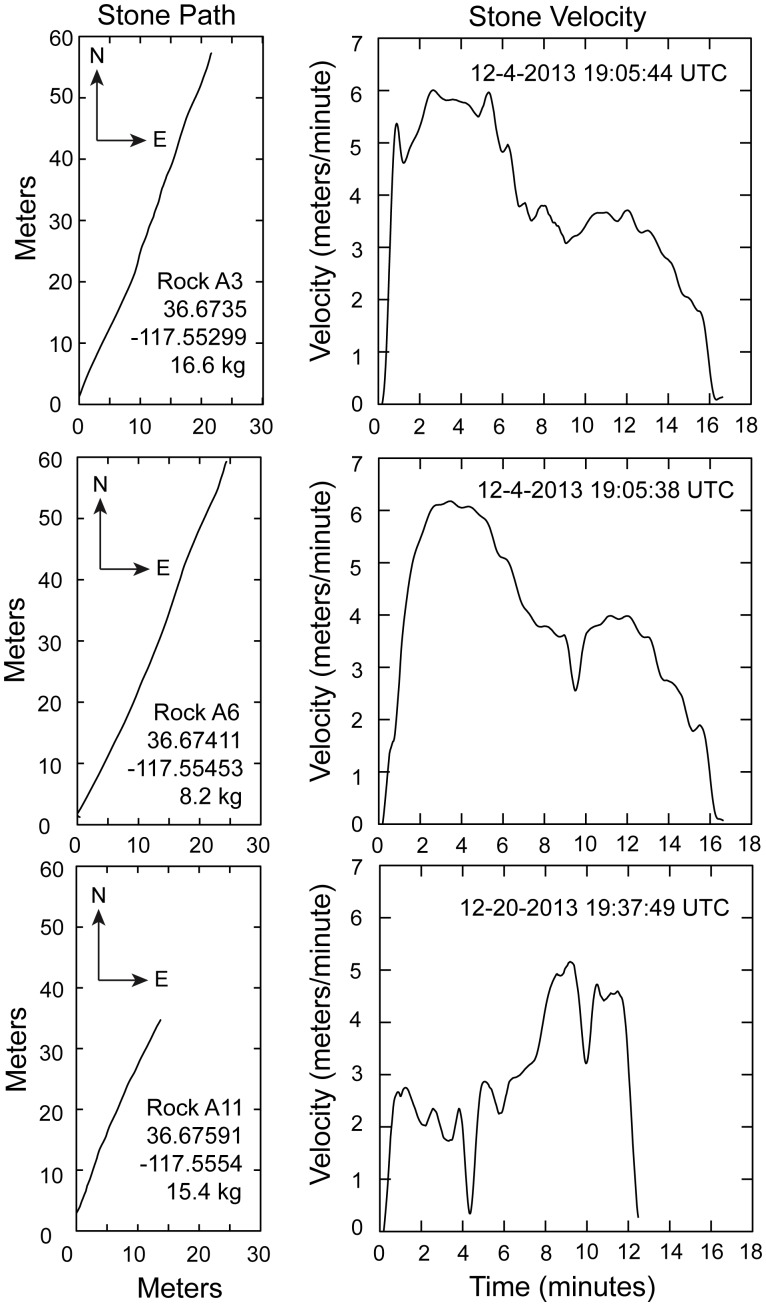
GPS-instrumented rock trajectories and velocity.Top and middle panels are data collected by rocks (A3 and A6) on December 4, 2013; bottom panels are for a rock movement on December 20, 2013 (Rock A11). Times are UTC. Note the broadly similar trajectories and velocity histories for rocks on December 4. Velocity errors are shown in Fig. 7. Data reported in Table S2. Rocks A3 and A6 moved at least once after their GPS instrument batteries were depleted and had total trail lengths of 157.5 m and 162.4 m, respectively (Table 1).